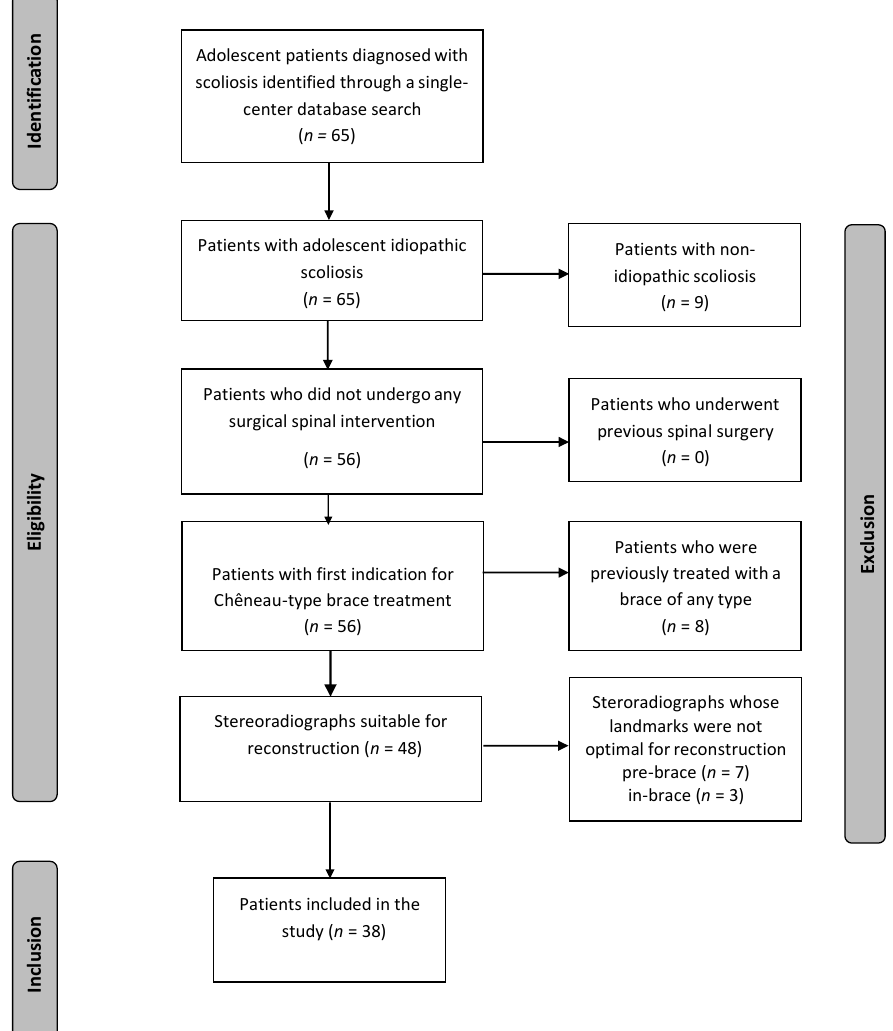
Figure 1. Flow diagram illustrating the inclusion/exclusion process of the study population.